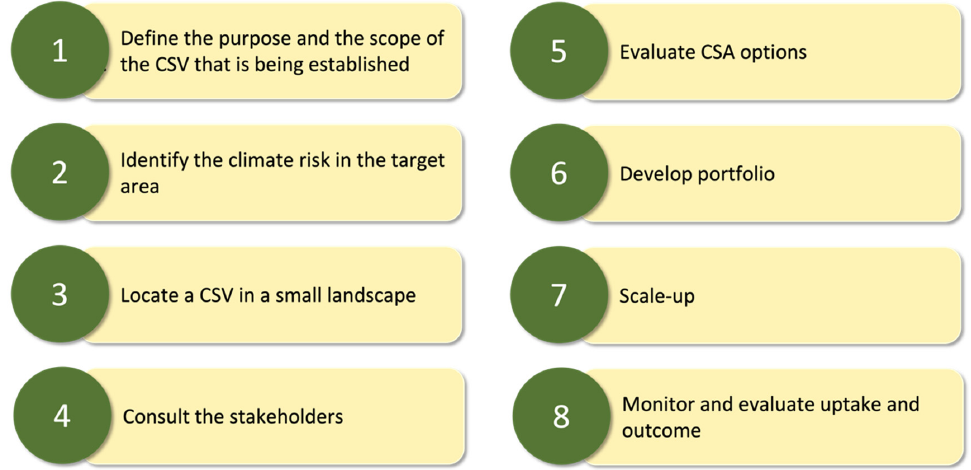
Figure 1. The 8-step framework for setting up a Climate-Smart Village. Figure adapted from [34]. In Vietnam, the CSV project was implemented in three villages, each managed by a different CGIAR research centre. The Ma CSV, in the northern mountainous Yen Bai prov- ince, was set up and managed by the International Centre for Tropical Agriculture (CIAT). The My Loi CSV, in Ha Tinh province on the north central coast, was set up and managed by the World Agroforestry Centre (ICRAF), and Tra Hat CSV, in the Mekong Delta, by the International Rice Research Institute